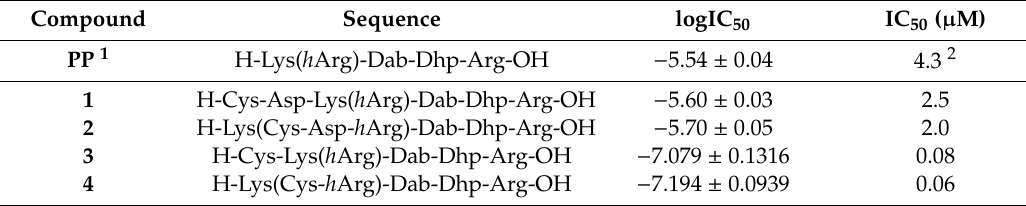
Table 1. Inhibitory e ff ect of branched peptides 1 – 4 on the VEGF-A 165 / NRP-1 complex formation.